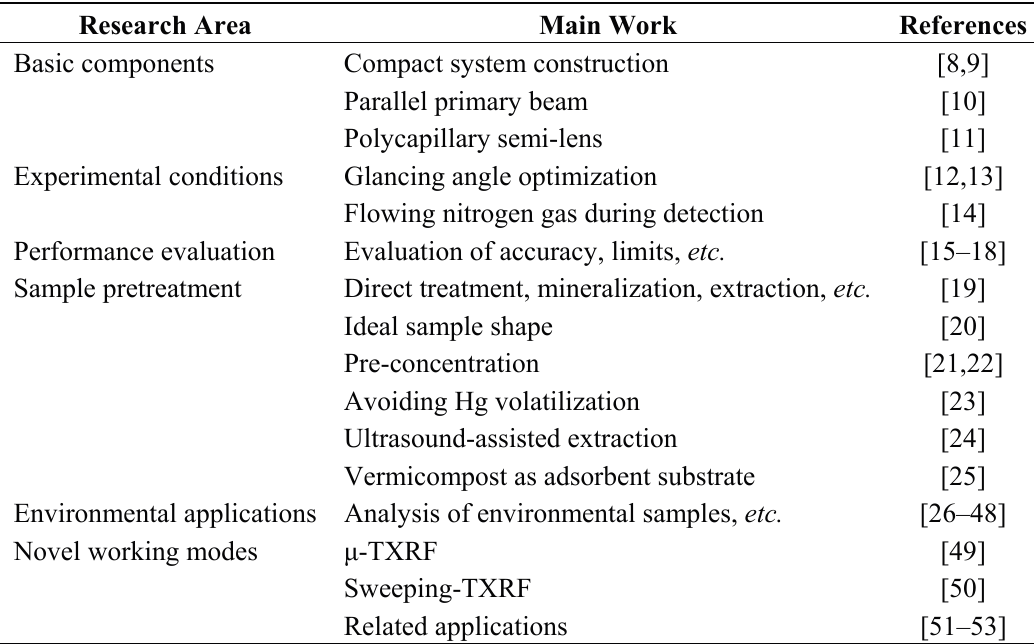
Table 1. Recent researches in the field of